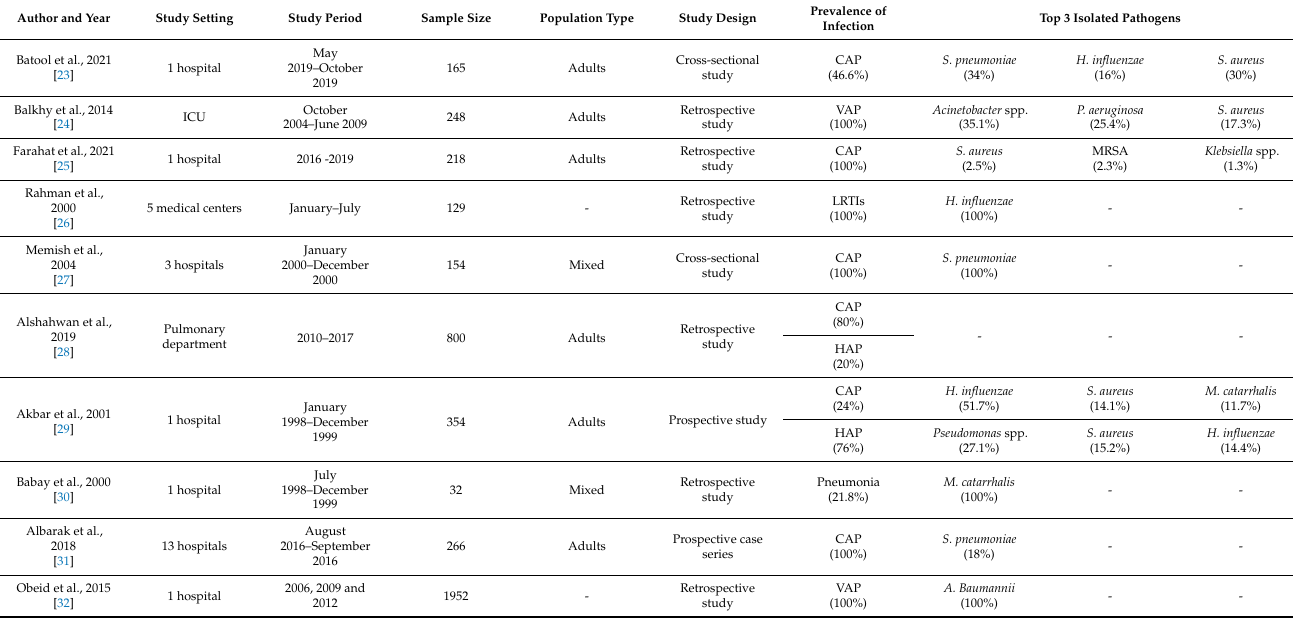
Table 1. Characteristics of eligible studies conducted in Saudi Arabia.